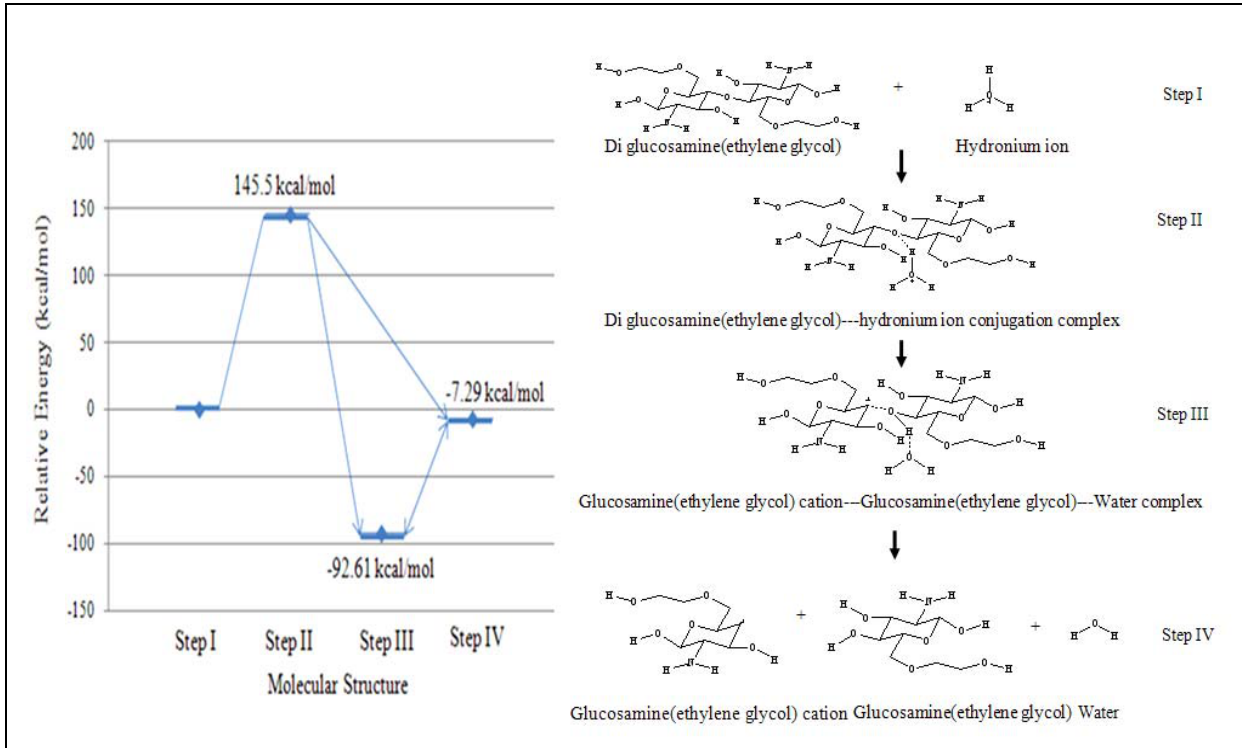
Figure 3. Relative energies of reaction intermediates during the acid hydrolysis of diglucosamine(ethylene glycol) calculated with B3LYP/6-31G//PM3. The